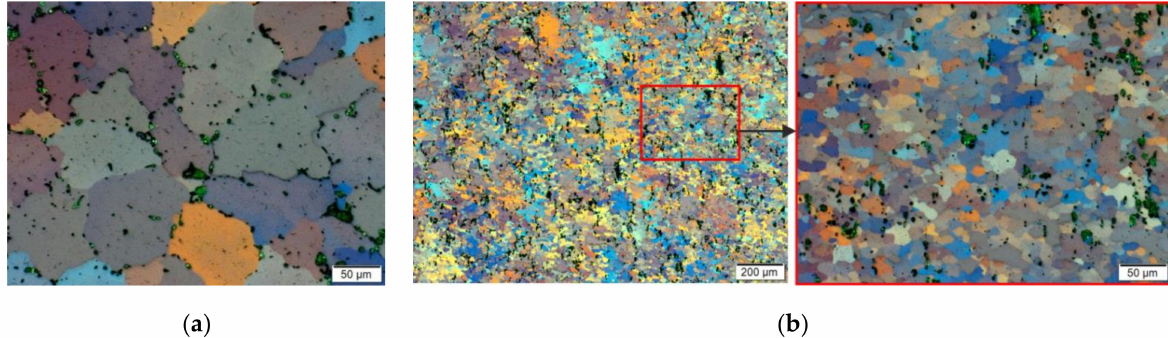
Figure 20. Microstructure of the 5019 aluminium alloy after plastic deformation: ( a ) centre of the sample; ( b ) edge of the sample; cross-section, magnification 200 × .